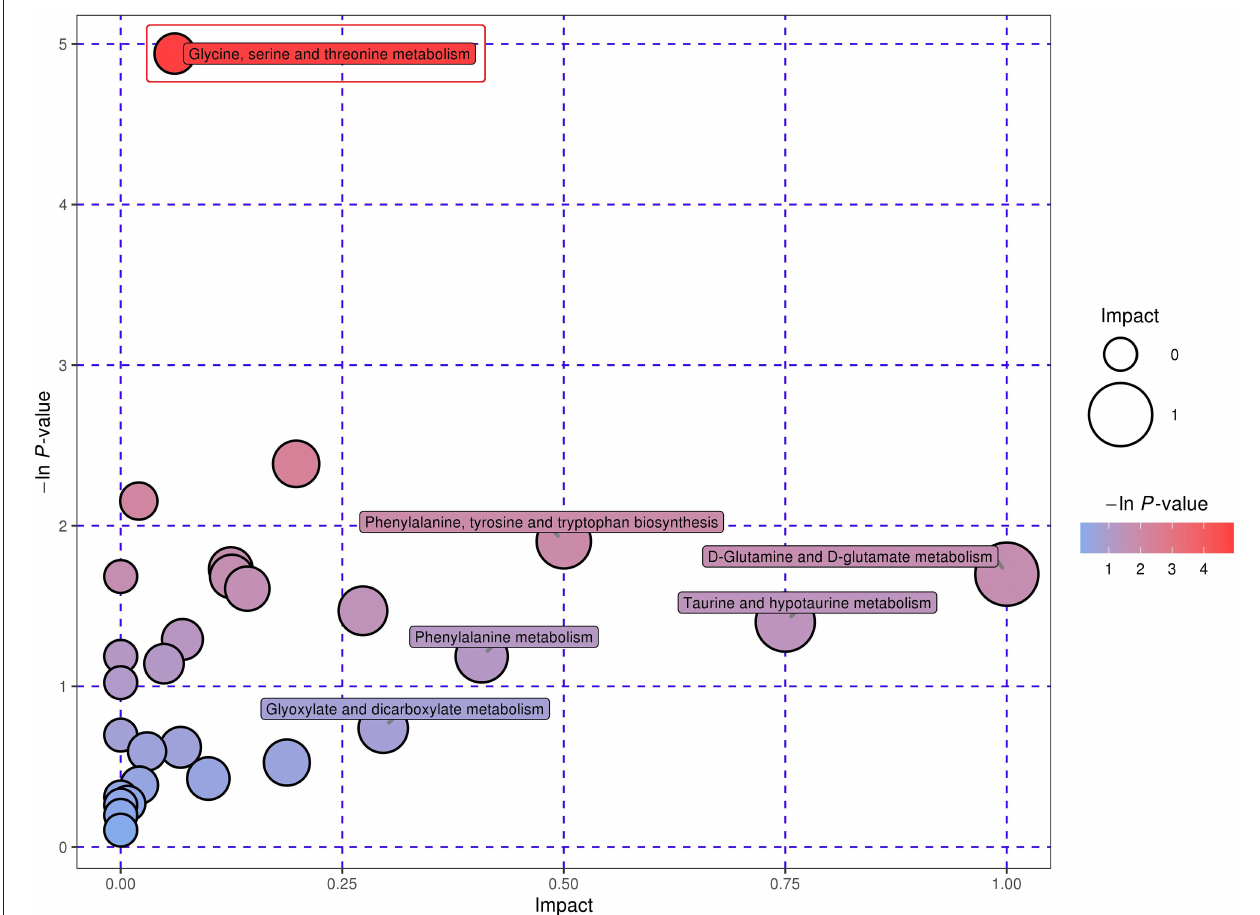
FIGURE 2 | Bubble plot demonstrating the common metabolic pathways in the four biofluids across two dietary treatments. The x-axis symbolizes the pathway impact, whilst the y-axis represents the pathway enrichment. The bubbles with larger sizes and darker colors represent pathways with higher impact values and higher enrichment. The red frame indicates that the pathway inside was identified with an enrichment p <